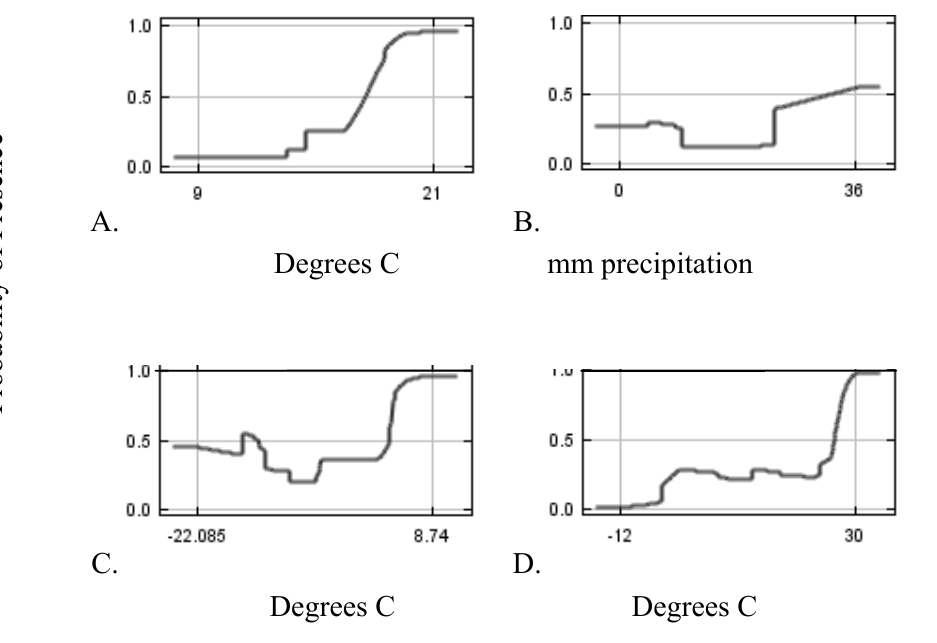
Figure 3. Response curves of the most influential predictors. (A) Mean Diurnal Range, (B) Precipitation of warmest quarter, (C) Minimum temperature of coldest month, (D) Mean temperature of wettest